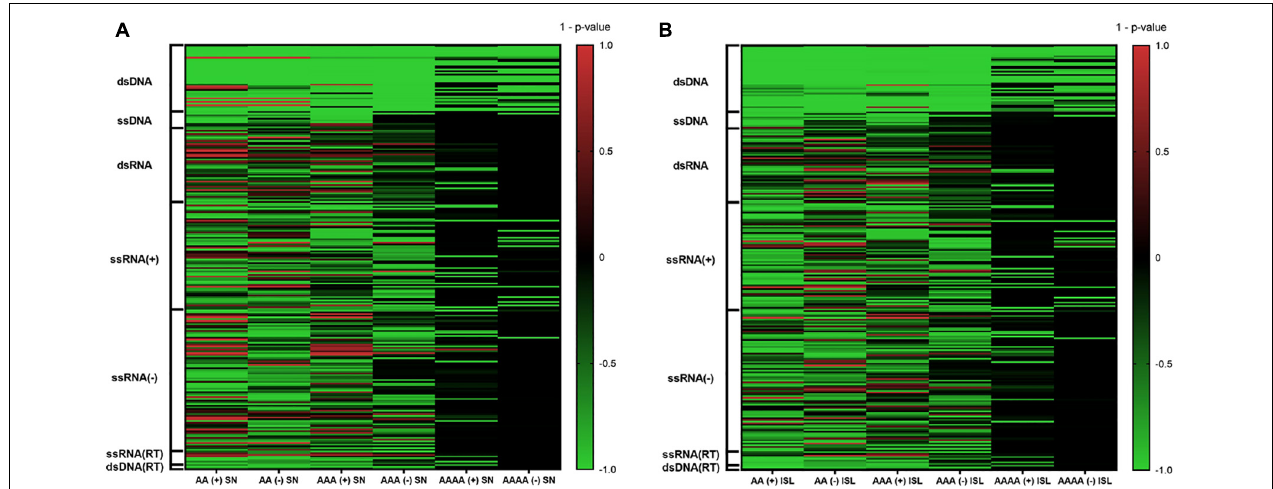
FIGURE 2 | Comparison of A-QLS abundance in real viral genomes vs. simulated genomes reshuffled at (A) single nucleotide and (B) island levels. Green and red indicate enrichment in real and simulated sequences, respectively.